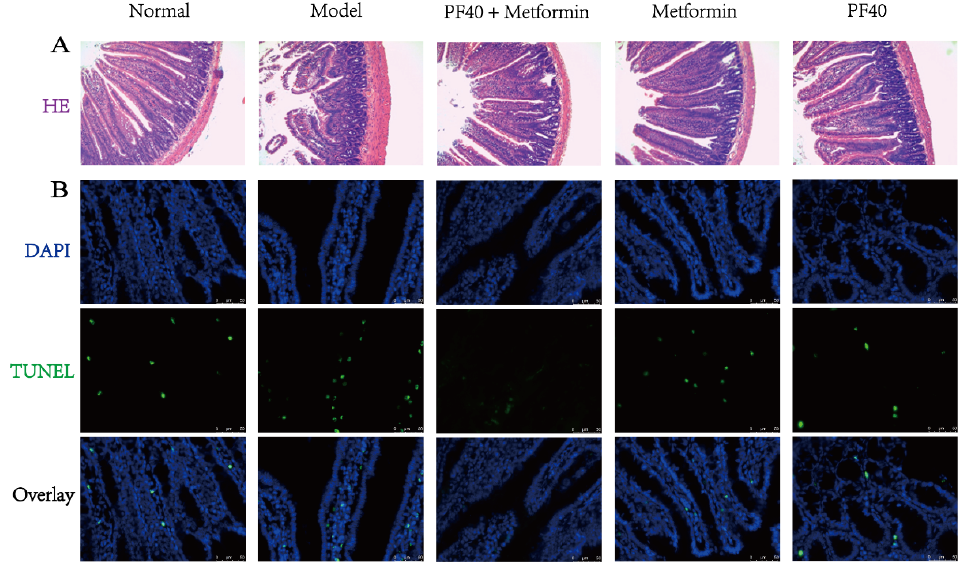
Figure 10. Effects of PF40 on histopathology of jejunum in T2DM rats: ( A ) HE staining, magnification ×200; ( B ) immunofluorescence images, magnification ×400, DAPI-labeled nuclei (blue fluorescence), and FITC-conjugated dUTP (green fluorescence) are indicated.